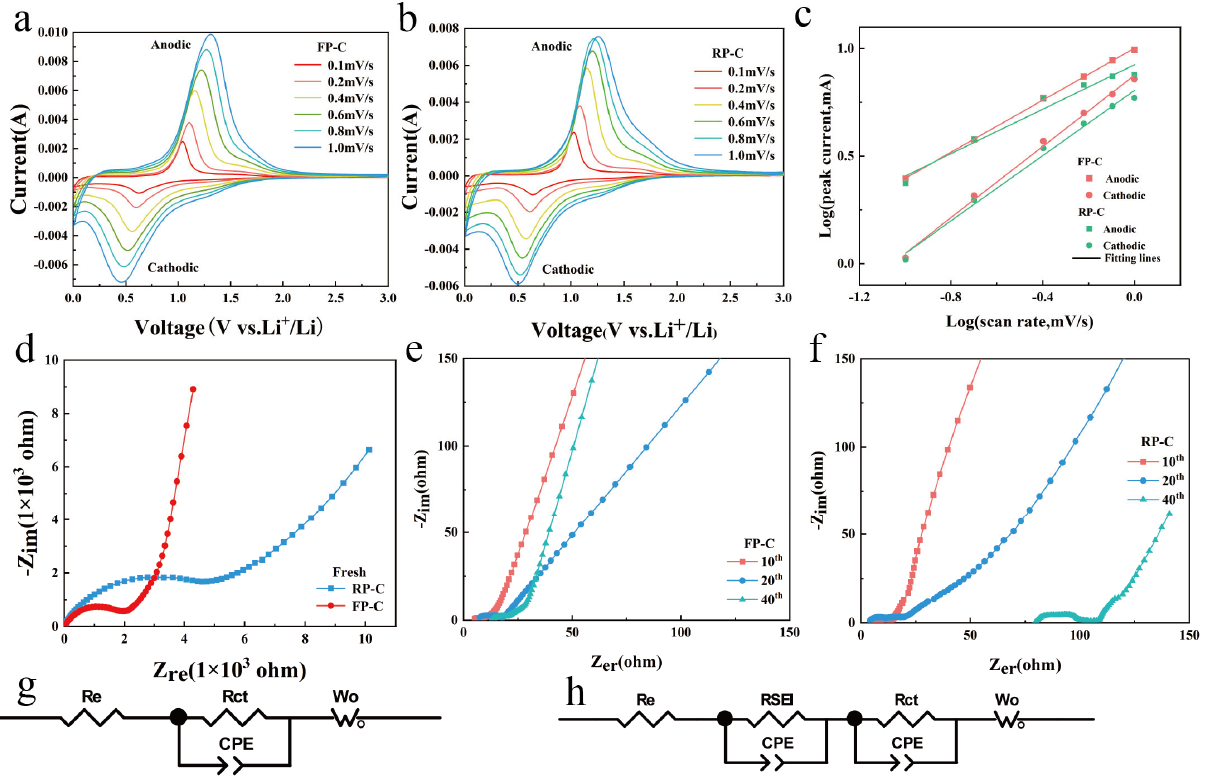
Figure 4. Electrochemical reaction kinetics of FP-C and RP-C electrodes for LIBs. CV curves of FP-C ( a ) and RP-C ( b ) at various scan rates from 0.1 to 1.0 mV/s for LIBs. ( c ) Log (peak current)-log (scan rate) curves for the observed cathodic and anodic peaks in ( a , b ). EIS Nyquist plots of fresh FP-C and RP-C electrodes ( d ). EIS Nyquist plots of FP-C ( e ) and RP-C ( f ) electrodes were tested after 10, 20, and 40 cycles at 0.2 A/g. Equivalent circuit ( g ) corresponding to ( d ) EIS spectra. ( h ) is the equivalent